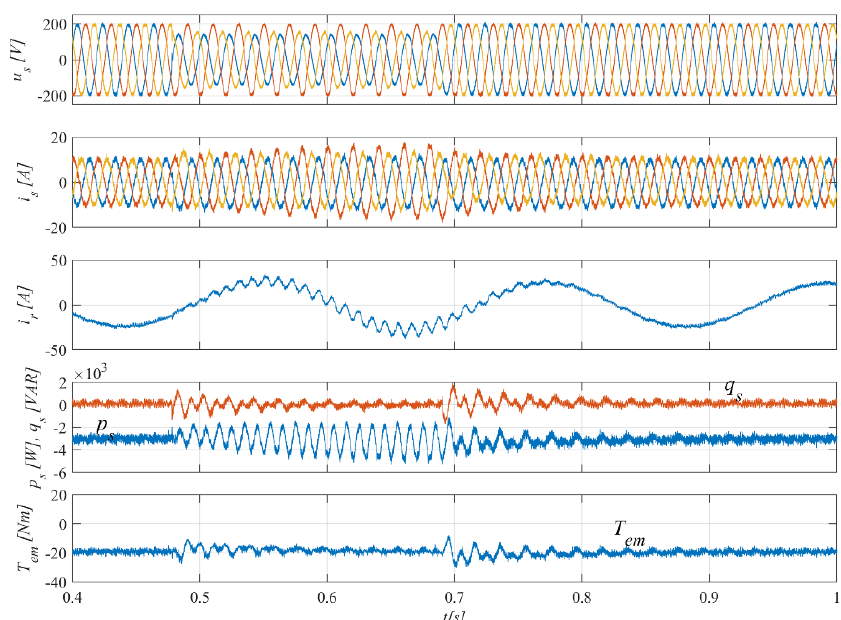
Figure 20. Experimental tests results of DPC showing transient performance in case of asymmet- rical grid voltage drop with the feedforward and decoupling mechanism included in the control, Q sref = 0, T emref = 0 Nm.